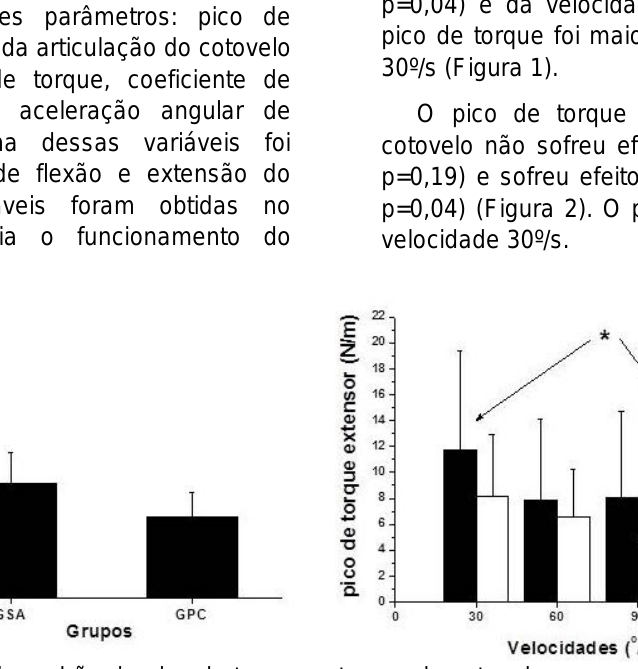
Figura 1. Média e desvio padrão do pico de torque extensor de cotovelo nos grupos GSA e GPC e média e desvio padrão do pico de torque das crianças dos grupos GSA e GPC divididos nas velocidades 30, 60, 90 e